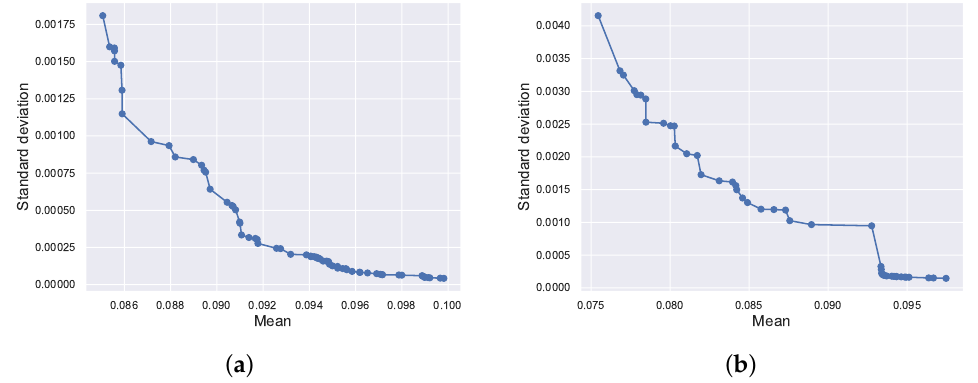
Figure 16. ( a ) The Pareto front solutions for 4 December given by the proposed method; ( b ) the Pareto front solutions for 11